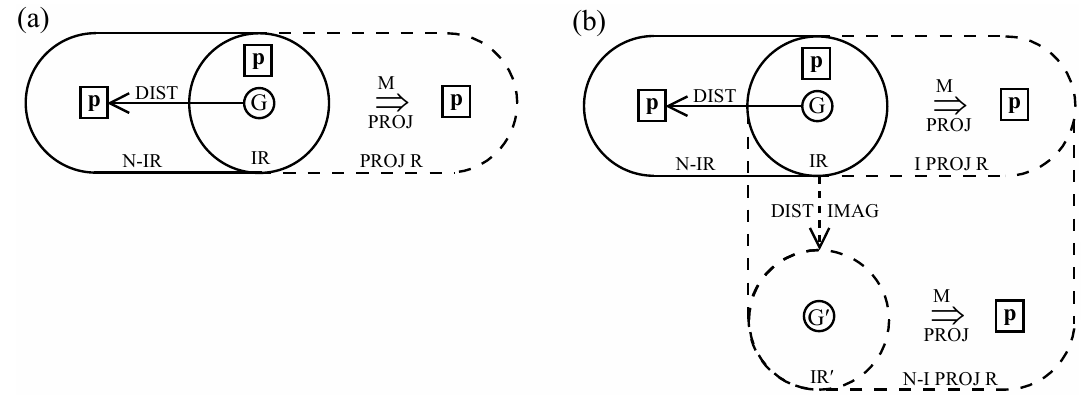
Figure 2. The grounding system with basic and elaborated modals.